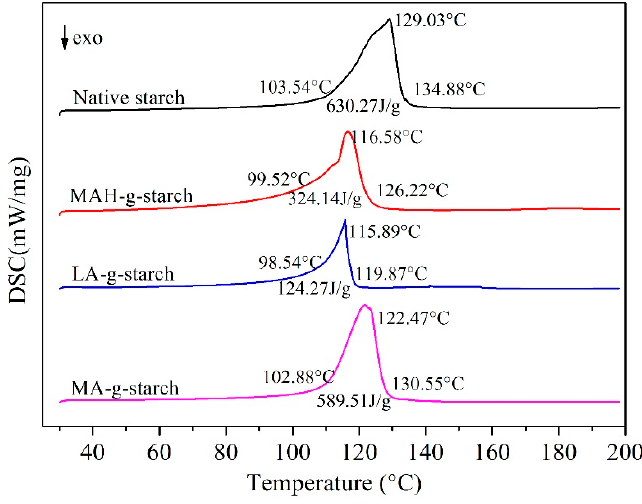
Figure 9. DSC curves of native starch and grafted starches.